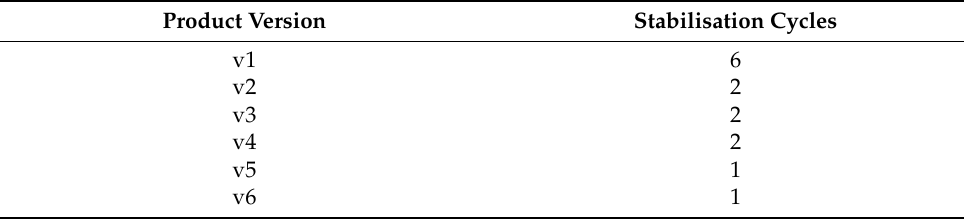
Table 3. Stabilisation cycles required to release a new version of the